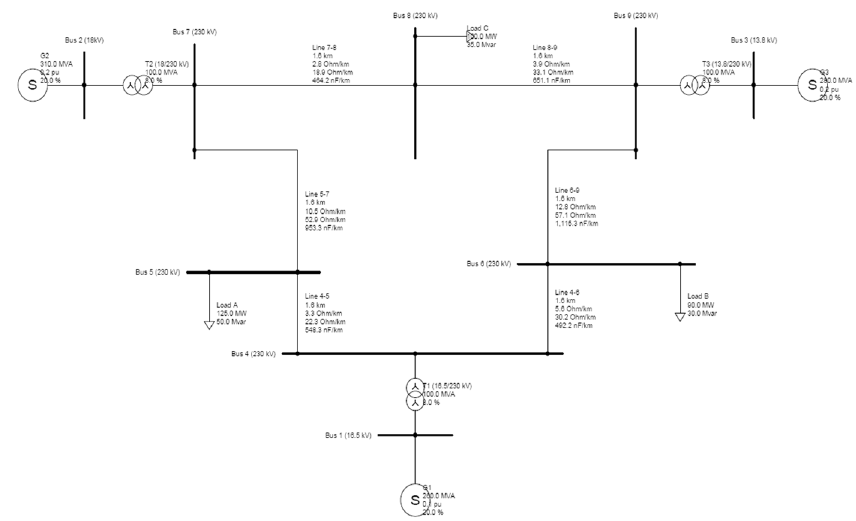
Fig. 1 The IEEE-9 bus topology with its input